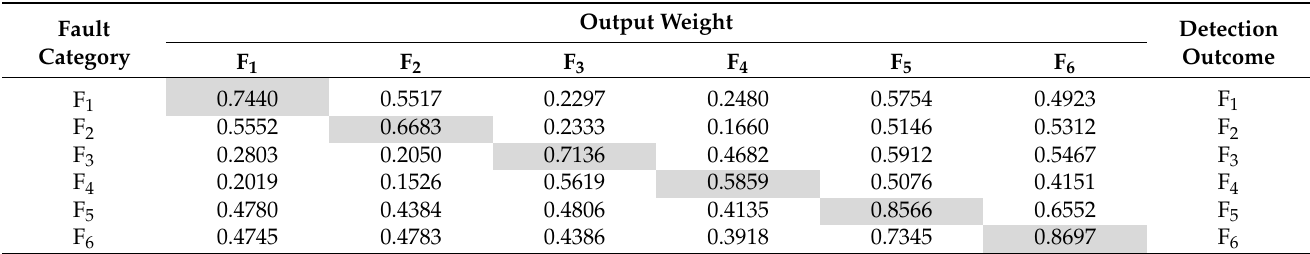
Table 6. Detection outcomes of the inverter at 85 Hz with different fault categories.